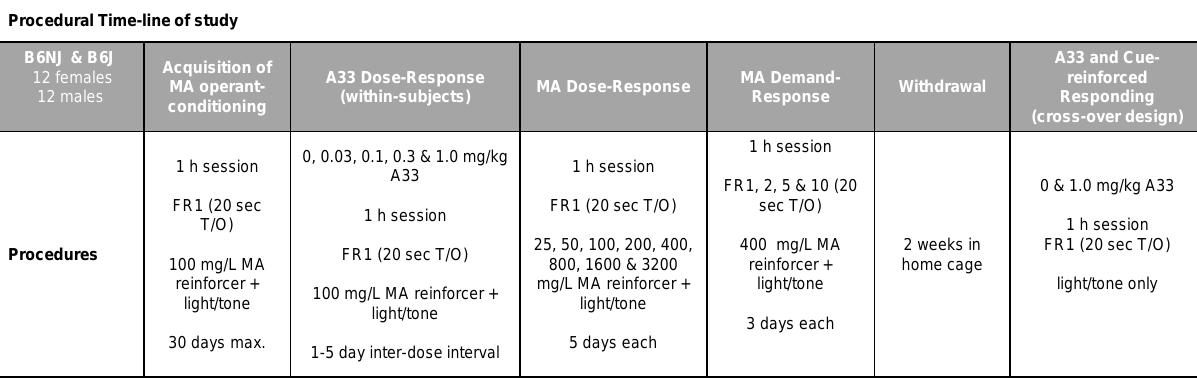
Figure 1. Summary of the procedural timeline for the MA study, which employed a within-subjects design to determine (1) sex and substrain differences in oral methamphetamine (MA) reinforcement and (2) the dose–response function for A33 effects upon oral MA reinforcement and the effect of 1.0 mg/kg A33 on cue-reinforced MA-seeking behavior.